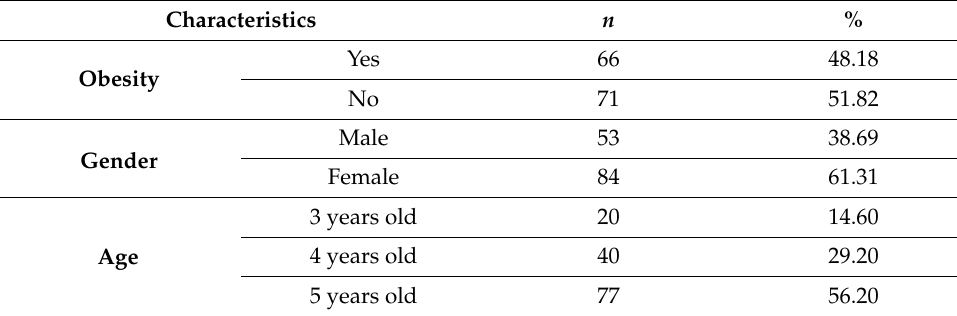
Table 1. Characteristics of research subjects ( n = 137).